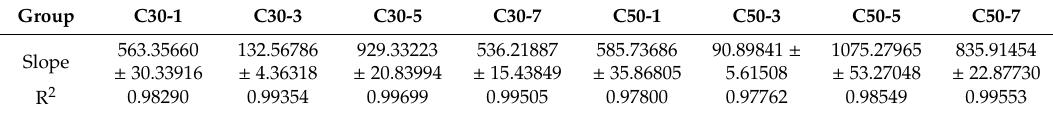
Figure 9. Correlation between drying shrinkage rate and moisture loss of AASC. Table 9. Correlation analysis results between drying shrinkage rate and moisture loss of AASC.